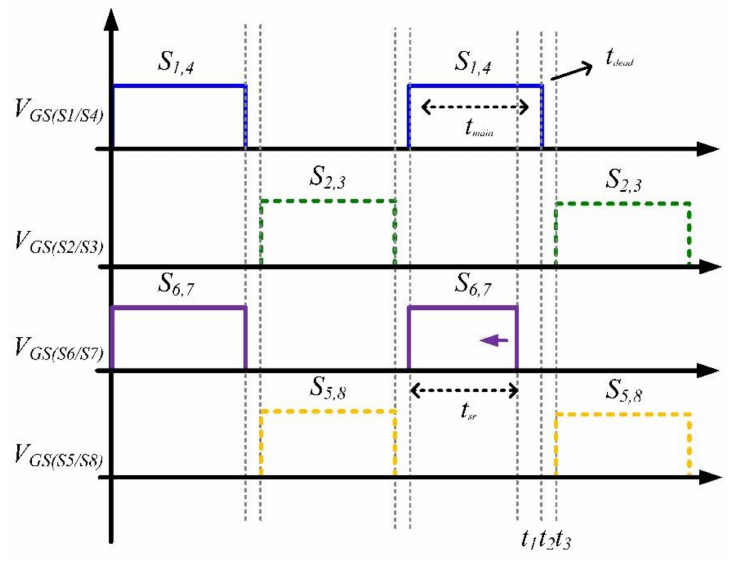
Figure 13. Lower limits of the SR